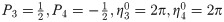
Four types of solutions for the coupled nonlocal Klein-Gordon eq (3).(a) Fundamental rogue wave solution |u| given by (35). (b) A mixed solution consisting of a rogue wave and periodic line waves with parameters (36). (c) A mixed solution consisting of a rogue wave and one breather with parameter P3=12,P4=−12,η30=2π,η40=2π. (e) A mixed solution consisting of a rogue wave, one breather and periodic line waves with parameters P3=23,P4=−23,p5=2,η30=π,η40=π,η50=0.